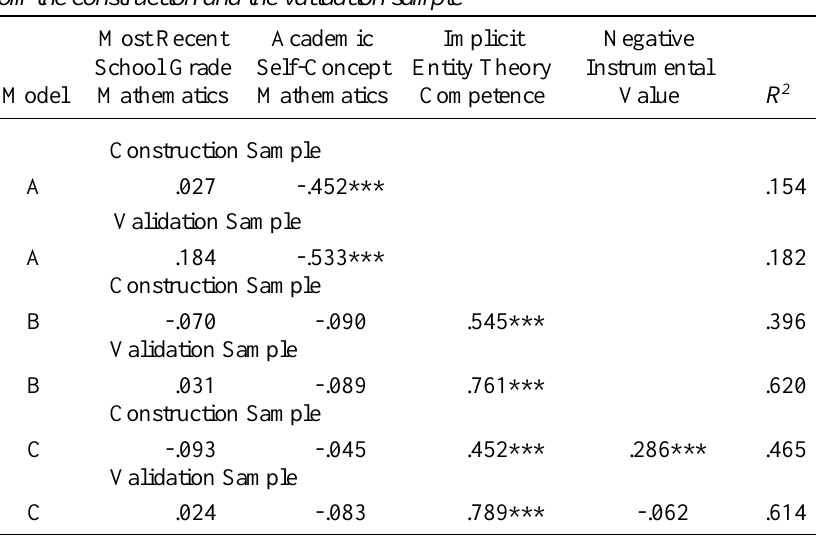
Multiple regression of WAESTA sum scores on background and self-belief variables (standardized beta weights and squared multiple regression coefficients):